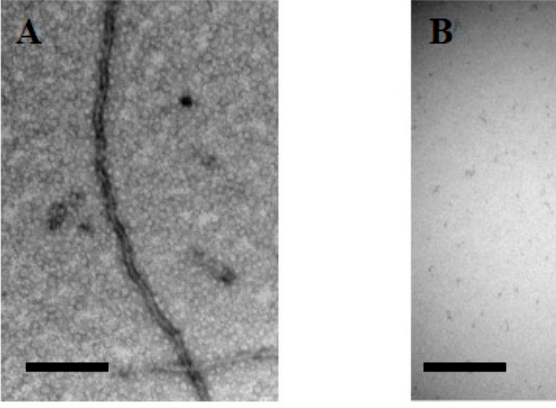
Figure 4. Electron microscopy of ( A ) heparin-induced synthetic fibers of Tau441 show the morphology of paired helical filaments, whereas ( B ) those of a TauF4 fragment devoid of cysteine residues show a morphology of two flat ribbons twisted around one another [126]. This morphology is found in the ex vivo 3R fibers characterizing Pick’s disease [127]; ( C) TauP301L after phosphorylation by Erk2 forms fibers without heparin. Scale bar = 100 nm.